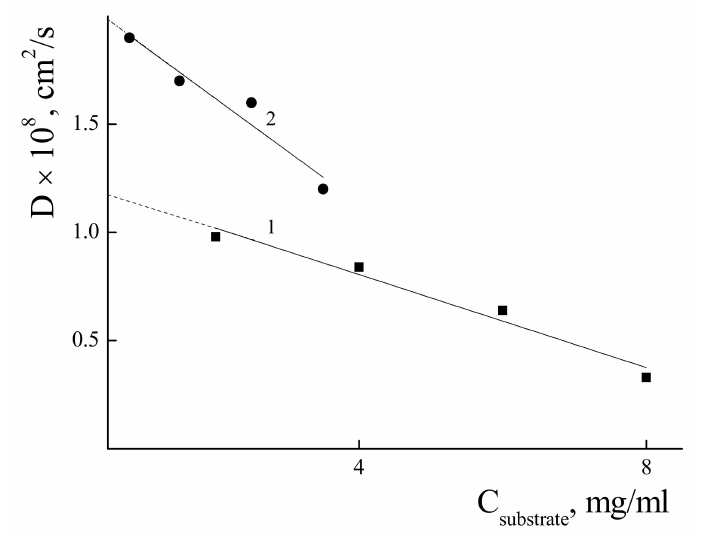
Figure 5. Dependence of the diffusion coefficient upon the concentration of a solution of PDADMAC (1) and IPEC (2) in a water-salt media. pH 7; C NaCl = 0.05